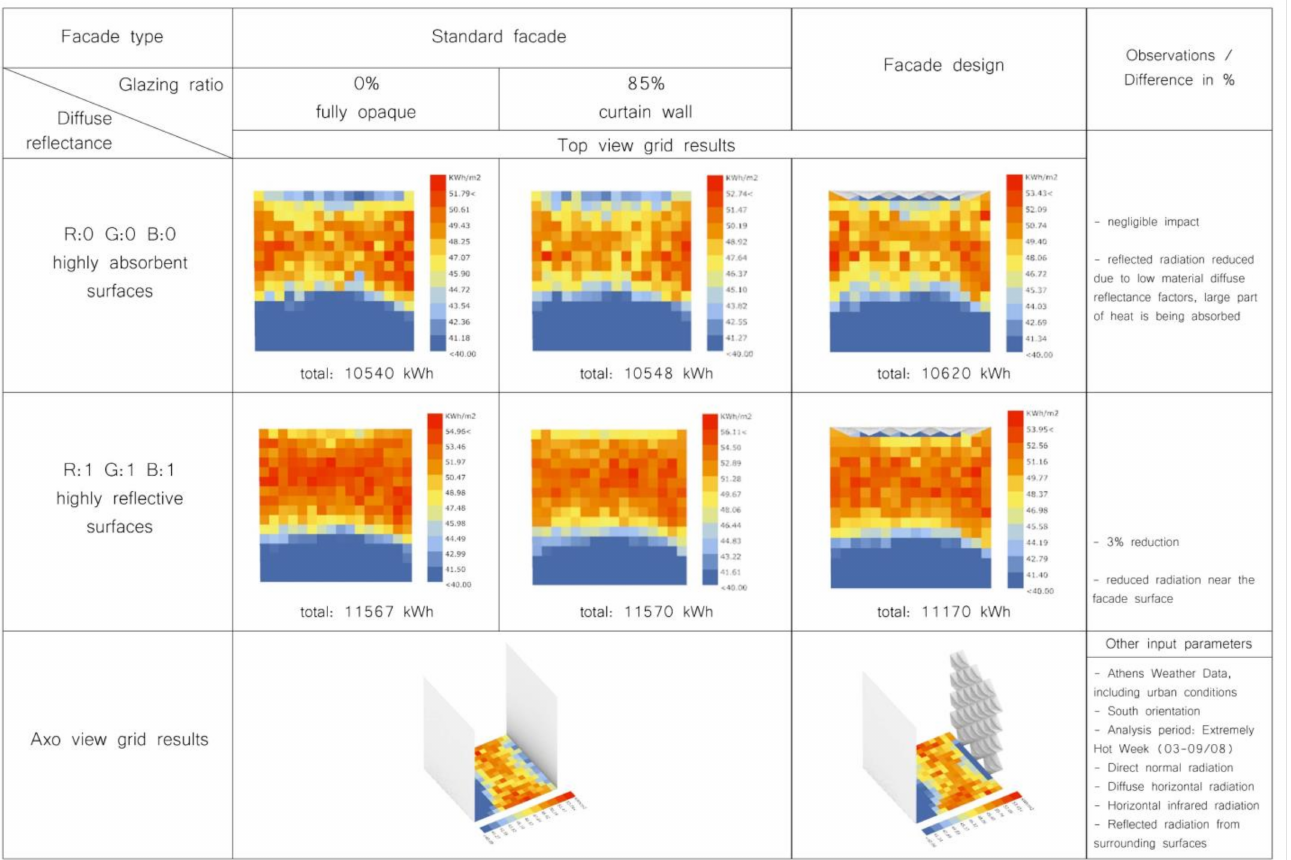
Figure 17. Cumulative radiation values on street level in an Athens urban canyon (cumulative radiation: direct, diffuse, and reflected radiation from all the surrounding